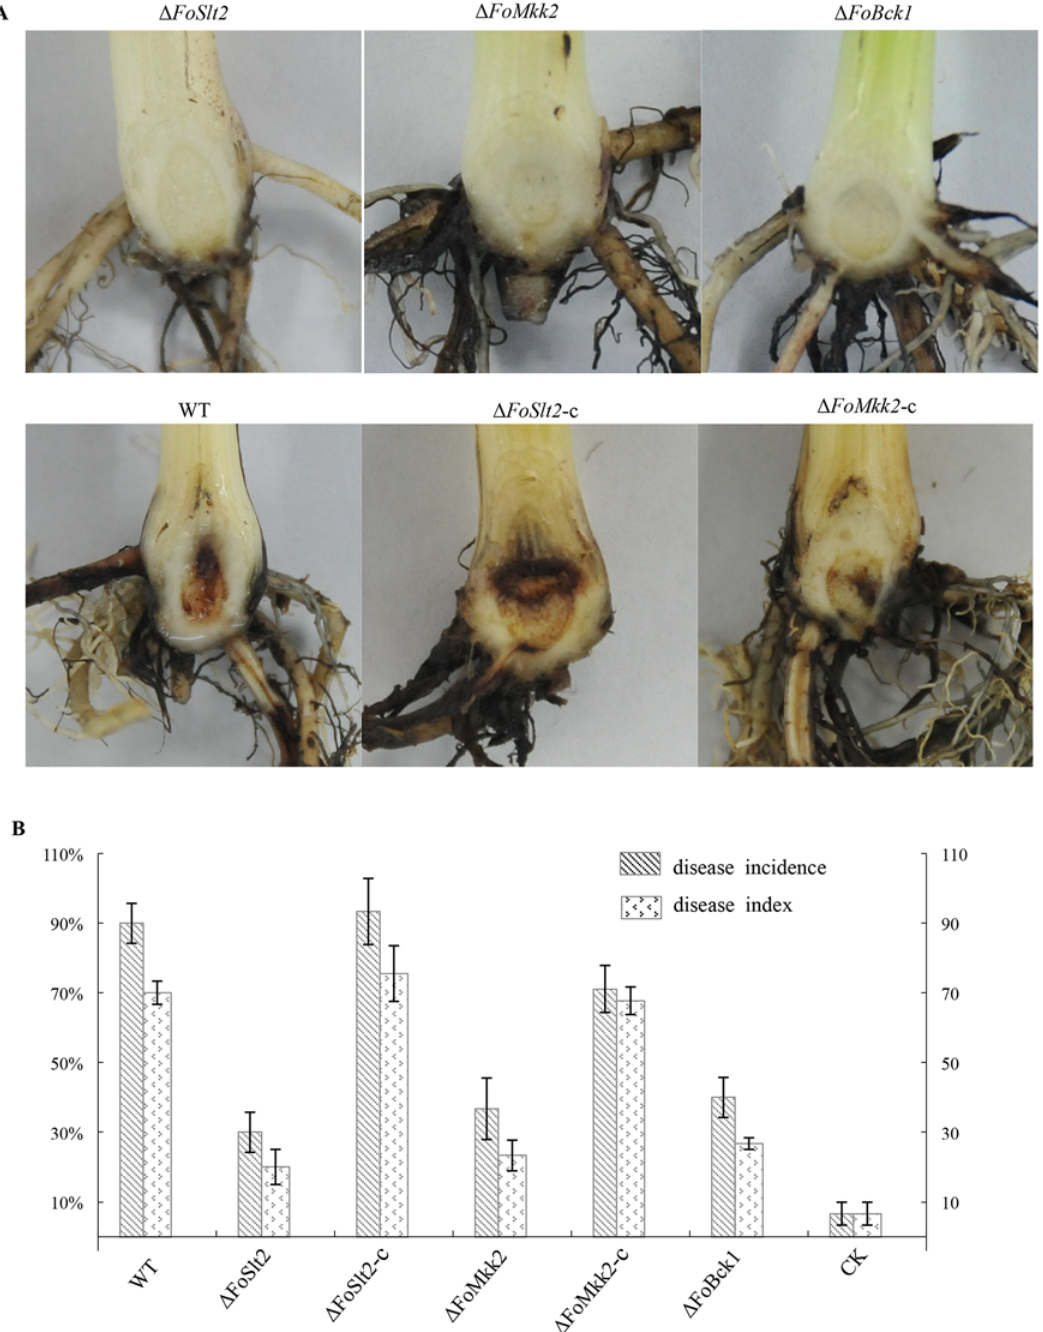
Fig 9. Virulence assay of WT, mutants Δ FoSlt2 , Δ FoMkk2 and Δ FoBck1 , and complemented strains Δ FoSlt2 -c and Δ FoMkk2 -c. (A) Disease symptom on corms of banana tissue plants were assayed after 40 days of inoculation with indicated strains and water as negative control. (B) Disease incidence and disease index indicated disease severity. Error bars indicate the standard error from three replicates.